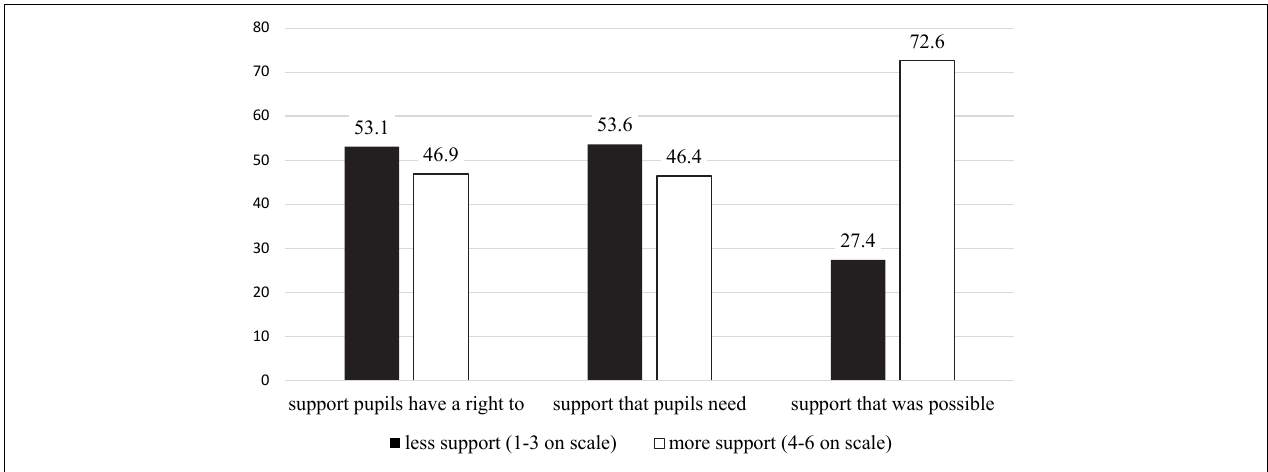
FIGURE 1 | Percentage of teachers indicating that students with SEN received more vs. less support in three areas during school closings.